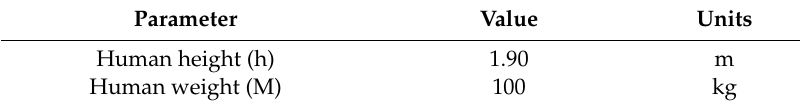
Table 1. Parameter values used in the proposed control